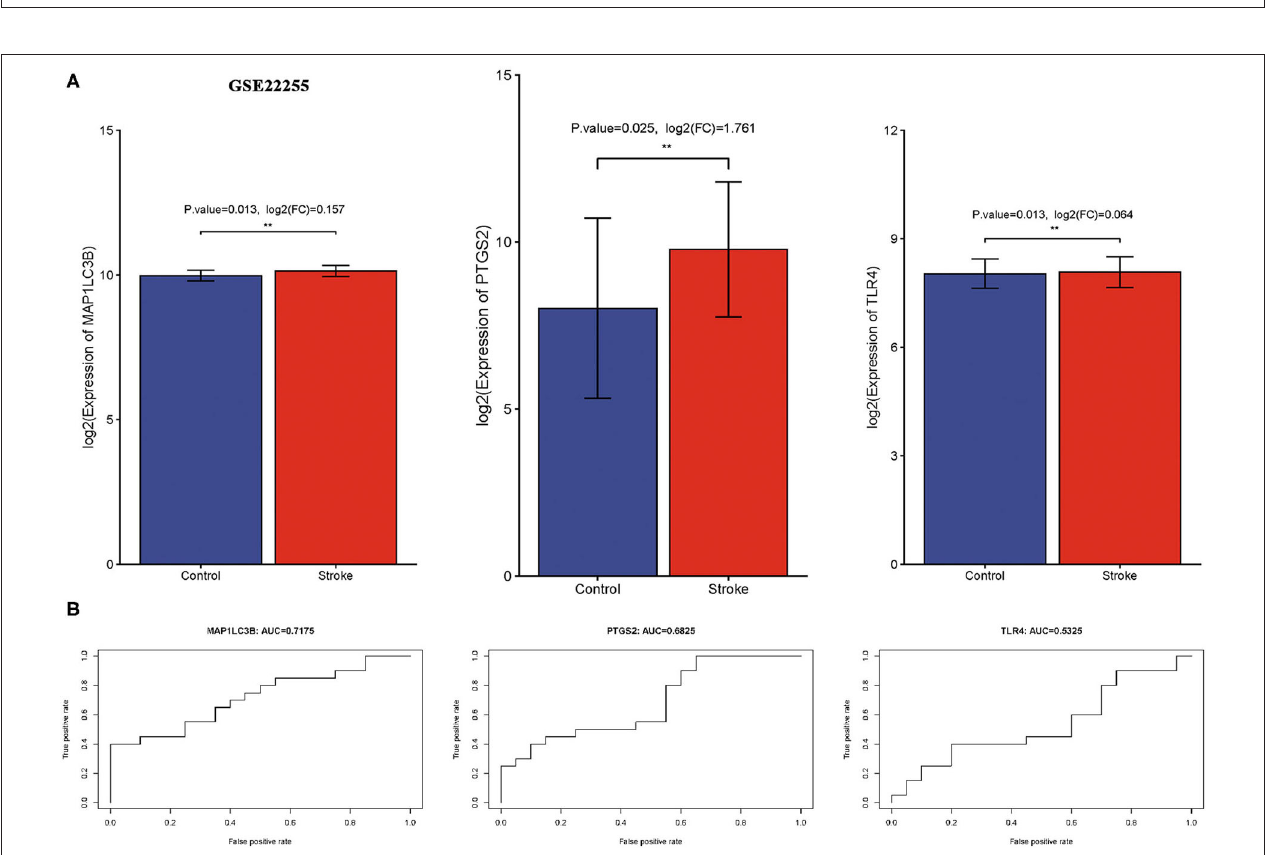
FIGURE 7 | Verification of expression and diagnostic value of ferroptosis-related biomarkers in ischemic stroke. (A) The expression of ferroptosis-related biomarkers in ischemic stroke vs. normal control cohort in the GSE22255 dataset. (B) The AUC of ferroptosis-related biomarkers in the diagnosis of ischemic stroke in ROC monofactor analysis in the GSE22255 dataset. ** p < 0.01.